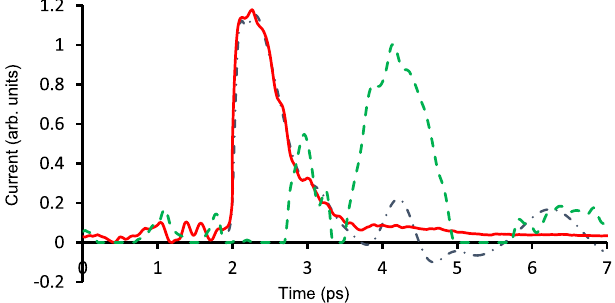
7. Reconstructions of the electron bunch profile, measured at FACET during E203 experiments [2], based on non-PCI (dashed green line) and PCI (solid red line) and minimal phase (dash-dotted blue line)